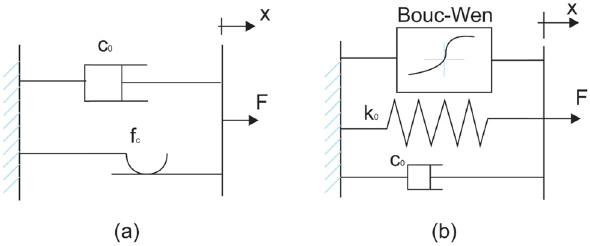
Figure 2: ( a ) Bingham model and ( b ) Bouc - Wen model.